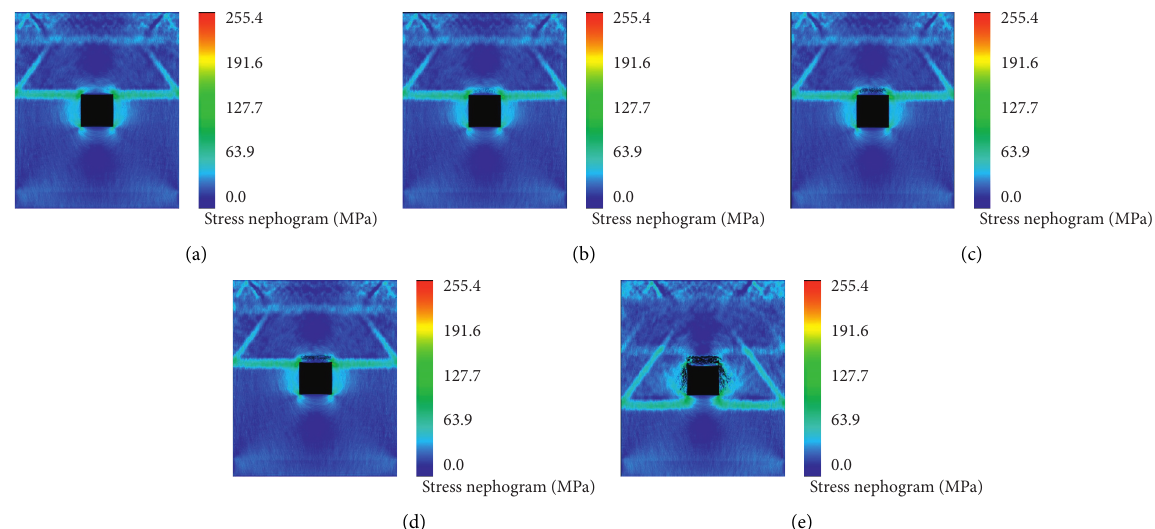
Figure 4: Fracture process of the numerical model without bolt. (a) ∼ (e) Loading step is 232, 233, 234, 235, and 330,